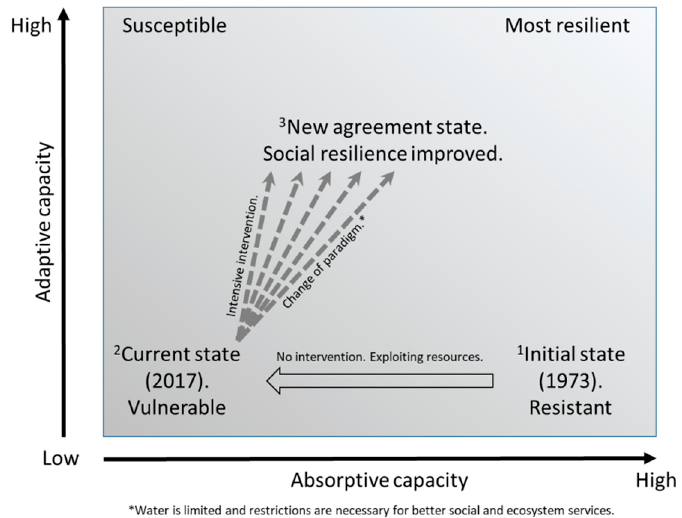
Figure 7. Resilience canvas for the Laja Lake basin, Chile. Canvas proposed by Mao et al. [38].